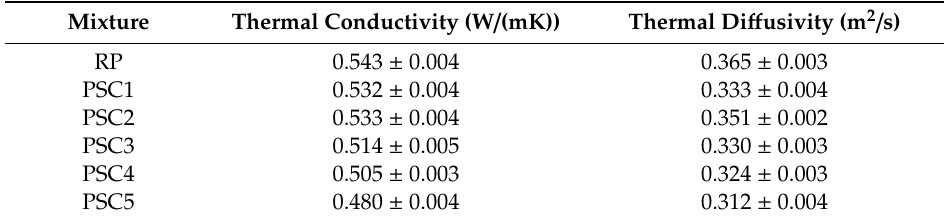
Table 4. Thermal properties of studied plasters.